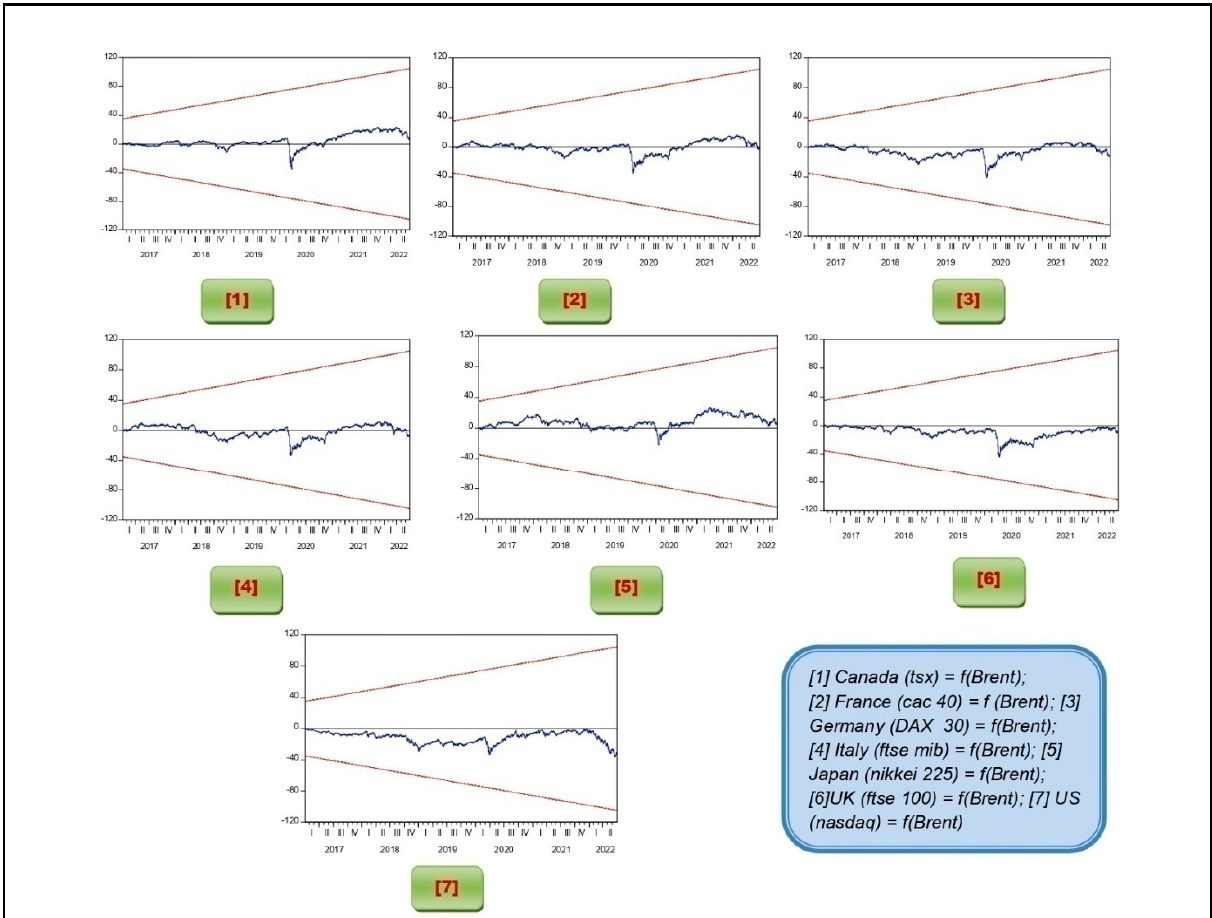
Figure 1. Plots of CUSUM for Parameter Stability between Brent Crude Oil Price and Stock. Indices of G7 countries. Source: Researchers’ own representations.